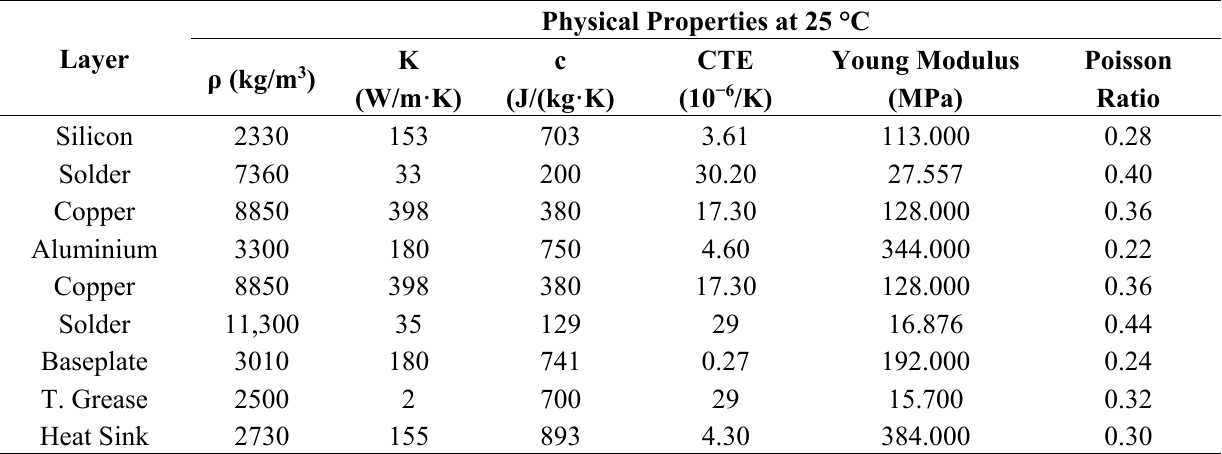
Table 1. Physical properties of each layer material at 25 °C